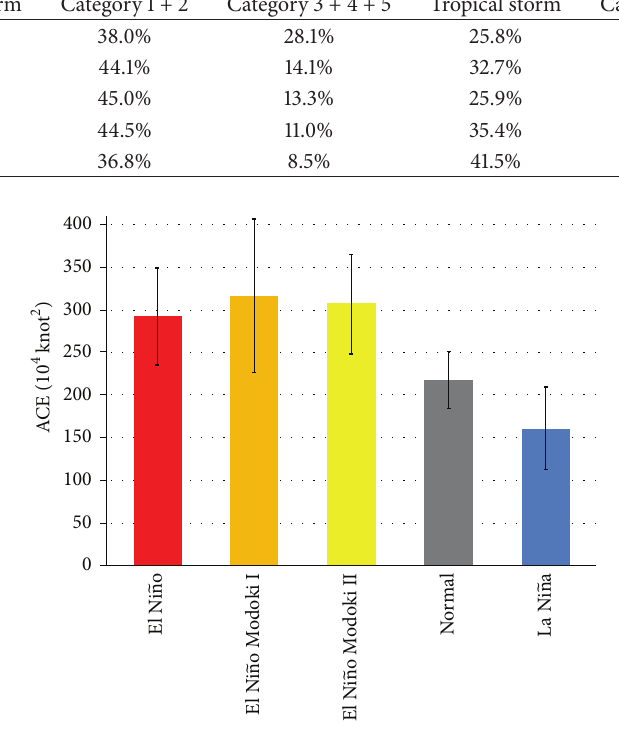
Figure 3: The mean of ACE of a year in the five events. The bar represents one standard deviation.